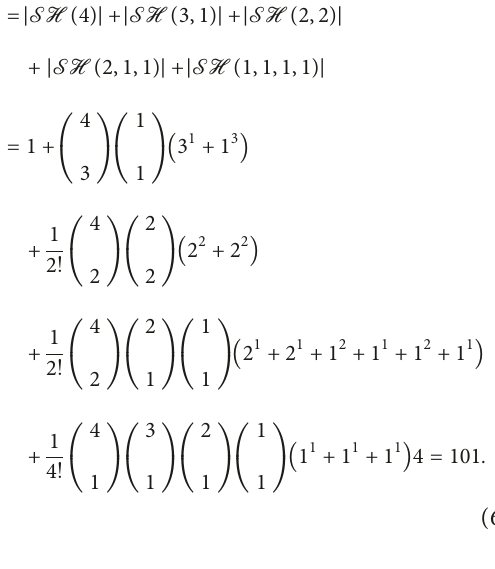
Figure 3: Superhypergraph H � ( X, S